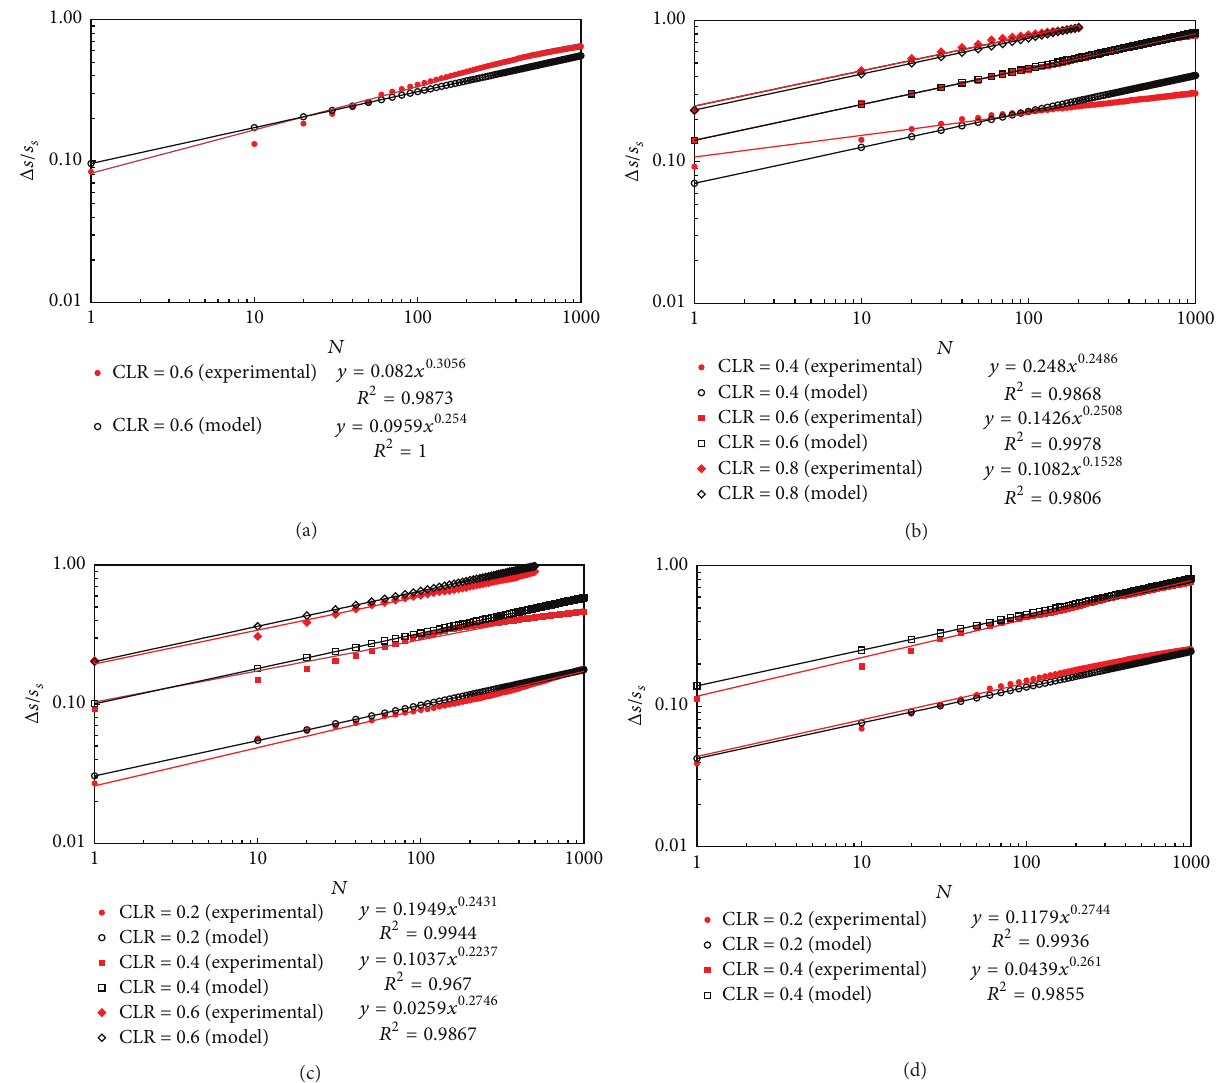
Figure 11: Variation of nondimensional accumulated displacement during dynamic load tests: (a) SLR = 0.0; (b) SLR = 0.1; (c) SLR = 0.2; (d) SLR = 0.3.